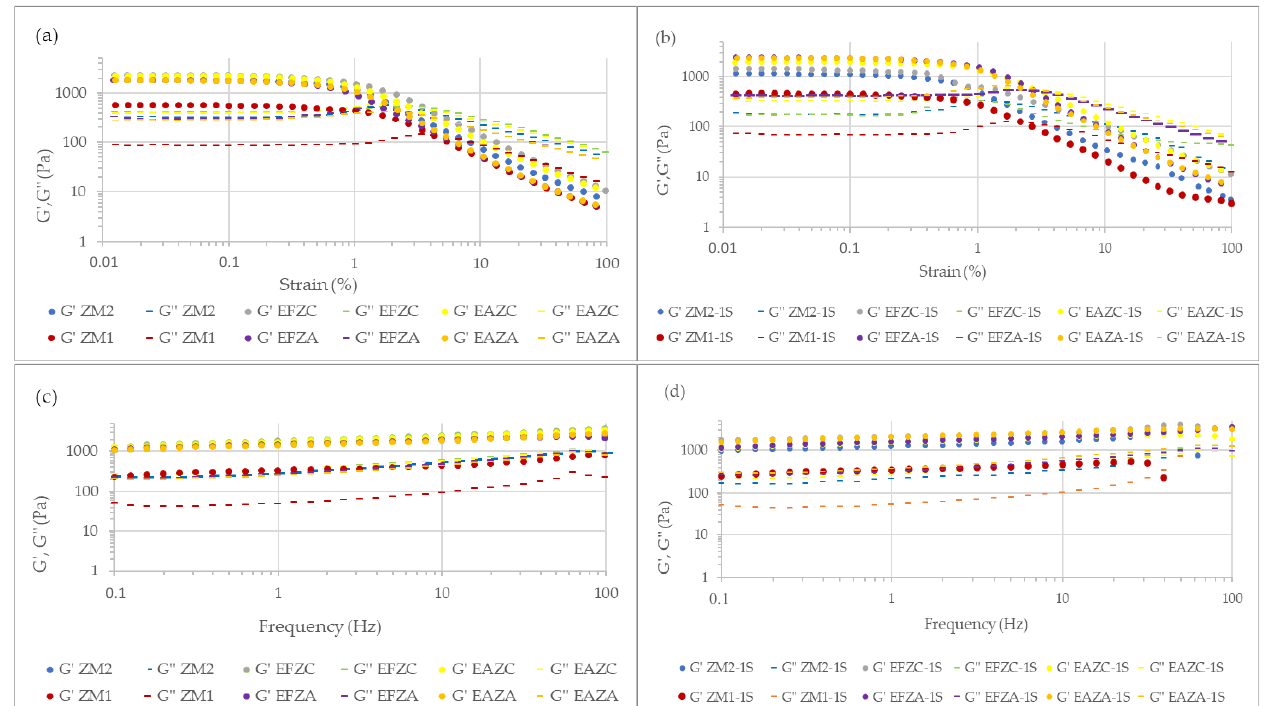
Figure 4. Strain ( a , b ) and frequency ( c , d ) dependent viscoelastic characteristics of zucchini purees fresh samples ( a , c ) and one-week stored samples ( b , d ). ZM 1 and ZM 2 are zucchini purees treated by steam convection and hot air convection, respectively; EFZA and EAZA are zucchini purees mixed with fennel or anise aqueous extract, processed by steam convection; EFZC and EAZC are zucchini purees mixed with fennel or anise aqueous extract, treated by hot air c onvection; “ - 1S” is added at each sample to differentiate one week of storage at refrigeration temperature.